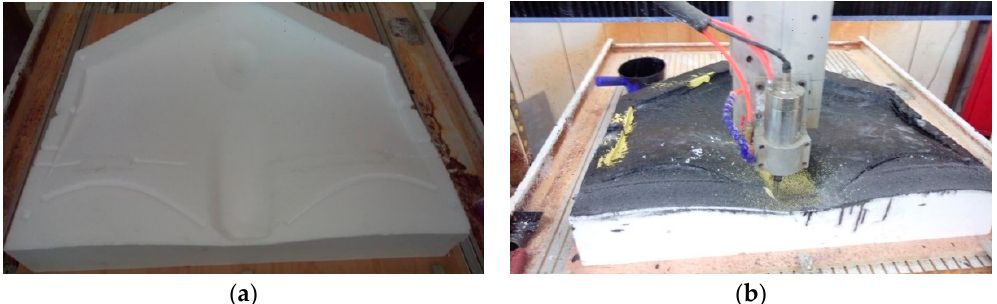
Figure 9. ( a ) Predesigned size of Styrofoam mold (fuselage) and ( b ) design size of mold consisting of Styrofoam, glass fiber, and epoxy resin (fuselage).